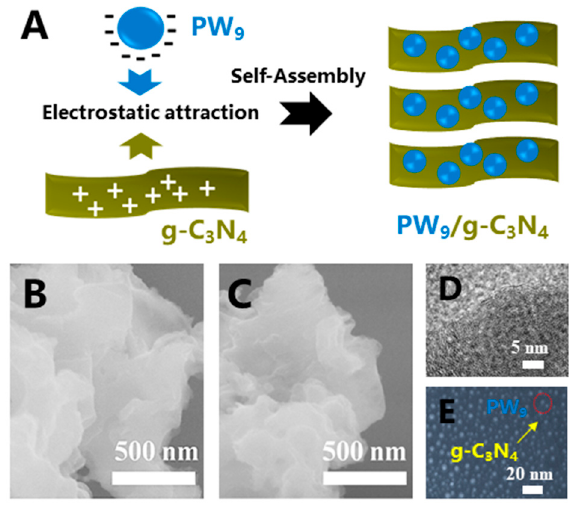
Figure 1. ( A ) Schematic diagram of the self-assembly process of the PW 9 /g-C 3 N 4 heterojunction NSs, based on the electrostatic force between these two hetero-components; SEM images of ( B ) g-C 3 N 4 NSs and ( C ) PW 9 /g-C 3 N 4 heterojunction NSs; the HRTEM image ( D ) and the dark-field STEM image ( E ) of the heterojunction NSs.